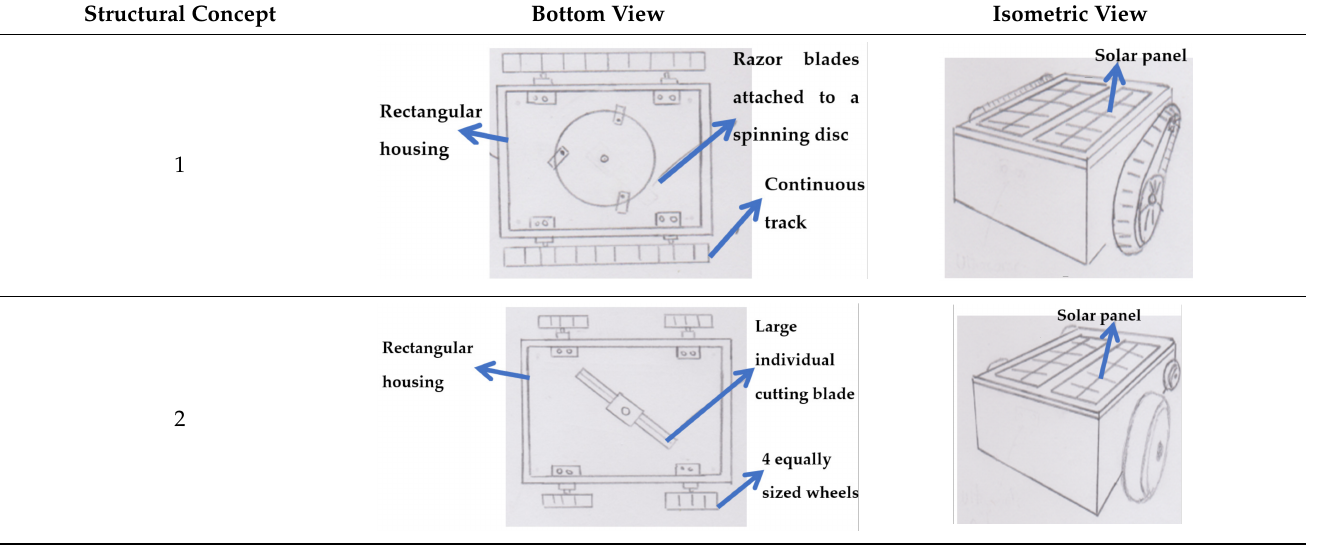
Table 3. Bottom and isometric views of the structural concepts (hand